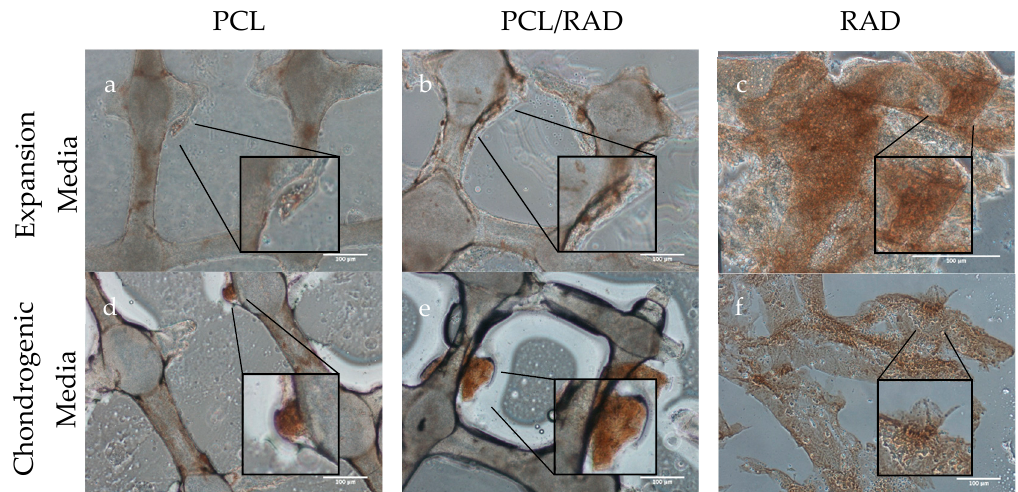
Figure 7. Immunohistochemistry composite picture of collagen type I staining. ( a – c ) PCL, PCL/RAD and RAD samples cultured in expansion medium. ( d – f ) PCL, PCL/RAD and RAD samples cultured in chondrogenic medium. Scale bar = 100 µm. n = 3.